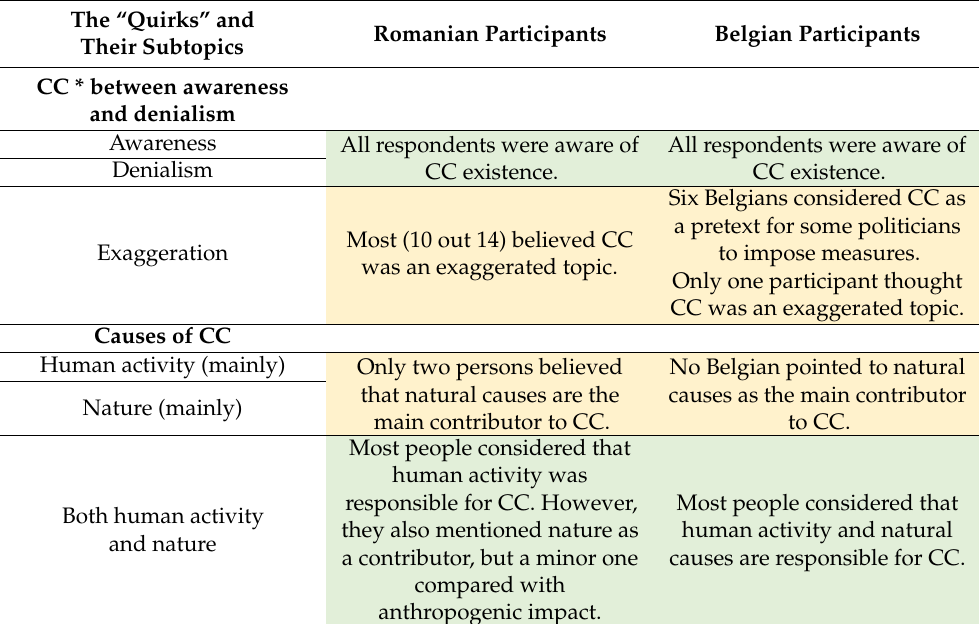
Table 3. Highlights of participants’ main views towards the “Quirks” and their subtopics and the commonalities (in green) and differences (in orange) between the Belgians’ and Romanians’